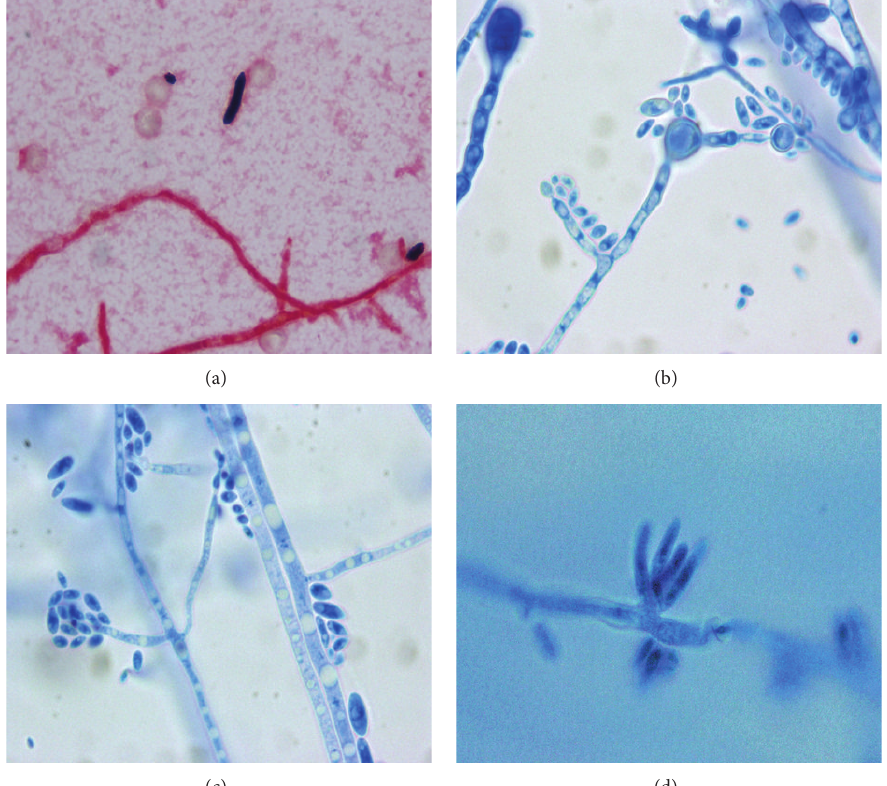
Figure 2: Gram stain of blood culture showing gram negative septated hyphae and gram positive microconidium and macroconidium (a). Lactophenol cotton blue slide preparations (LPCB) showing septated hyphae with intercalary chlamydoconidia (b) (X1000). Septated hyphae with straight simple thin long phialide bearing oval microconidia in a “diphtheroidal” pattern (c) (LPCB, X1000). Macroconidia in clusters, arising on a small conidiophore (d) (LPCB,